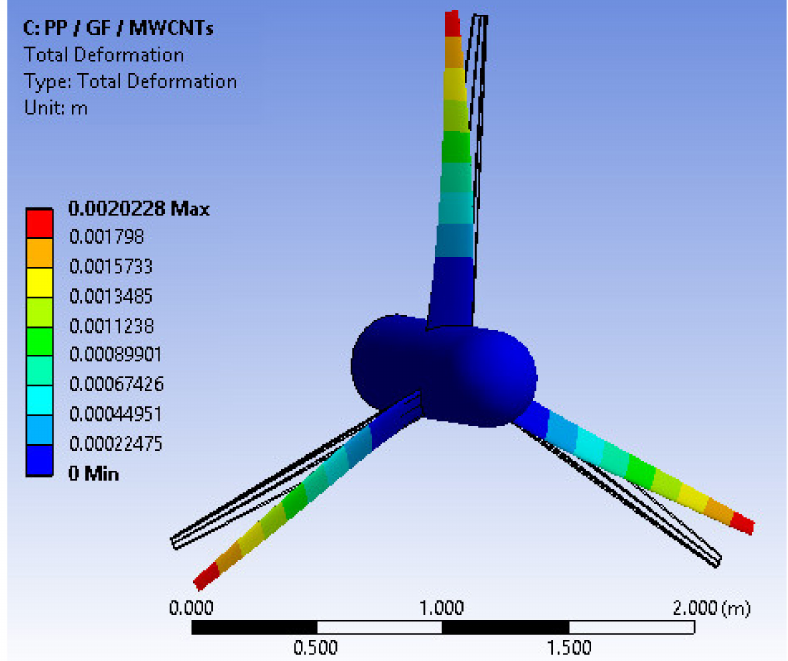
Figure 12. Graphical representation of maximum turbine blade deformation with PP/GF/MWCNT content at TSR = 3.